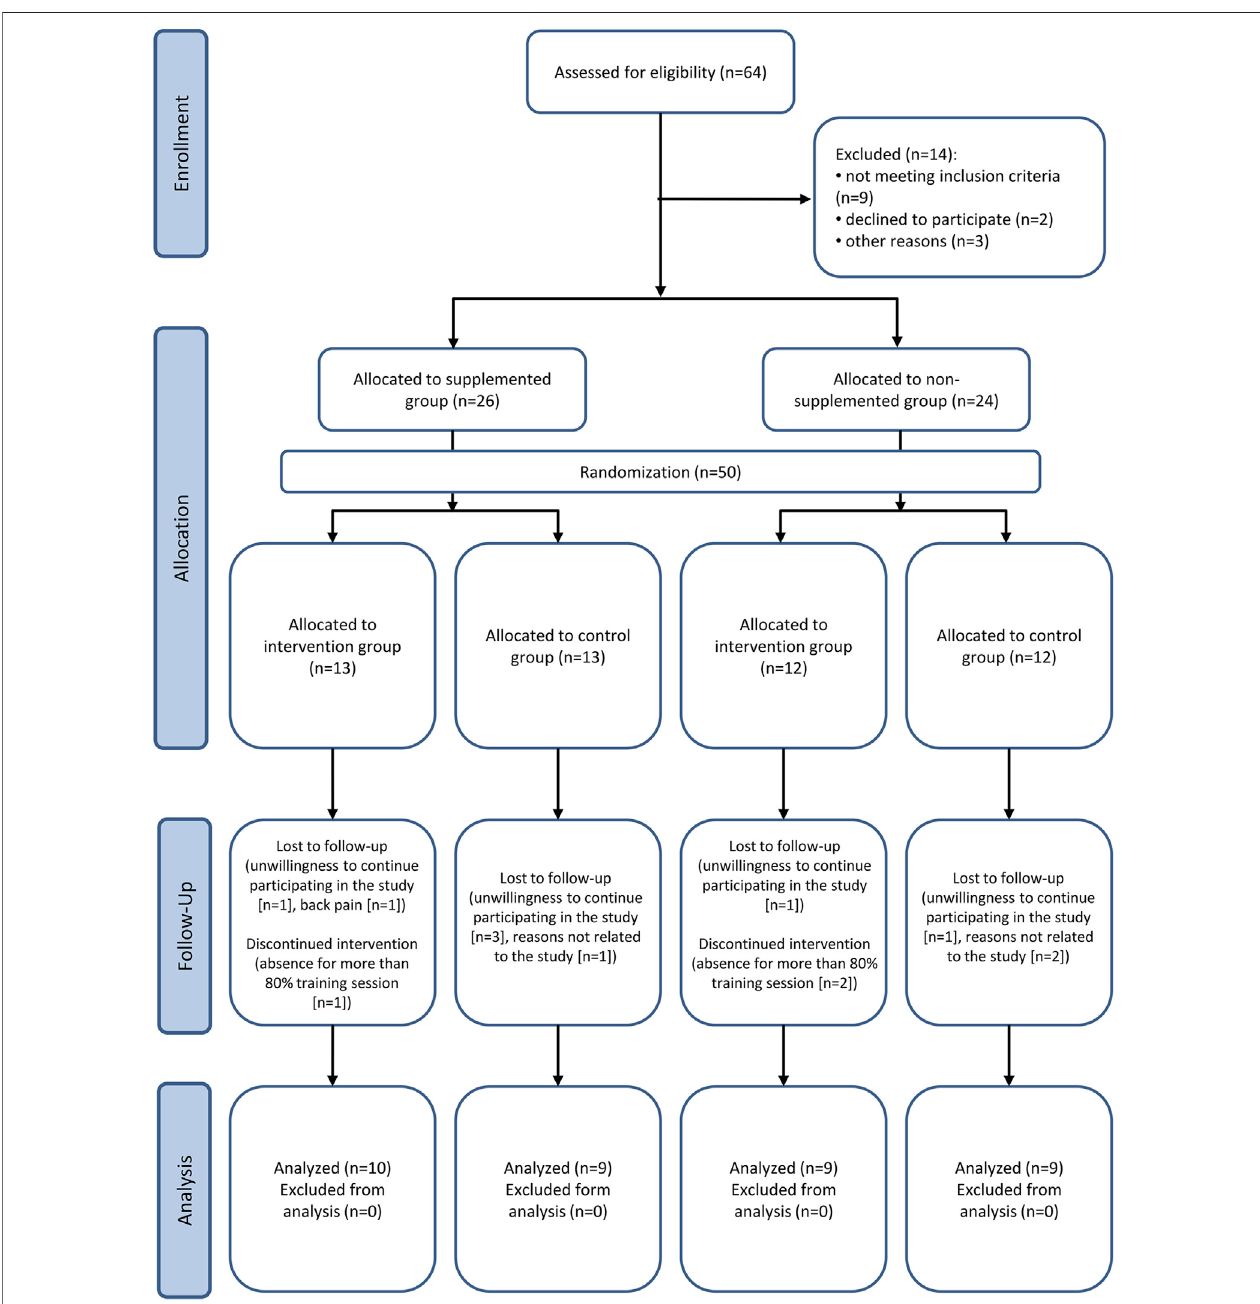
FIGURE 1 | CONSORT fl ow diagram of the